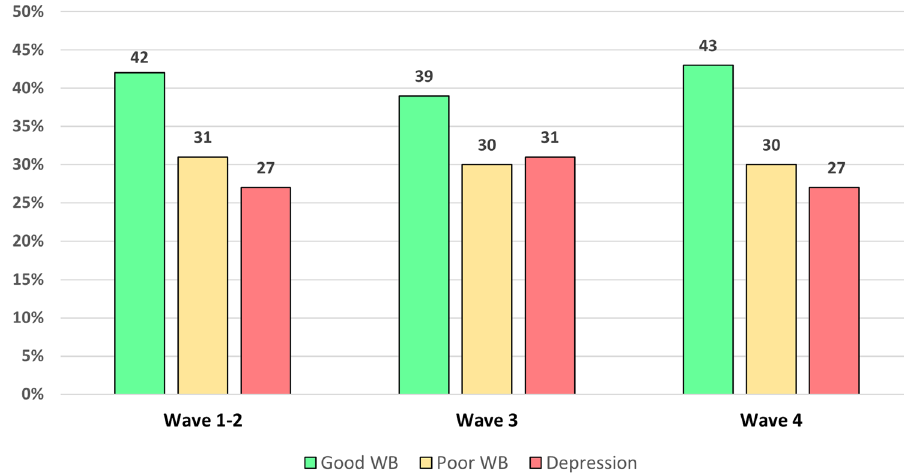
Figure 1. Percentages of WHO-5 categories across 4 waves in the Italian survey (N =